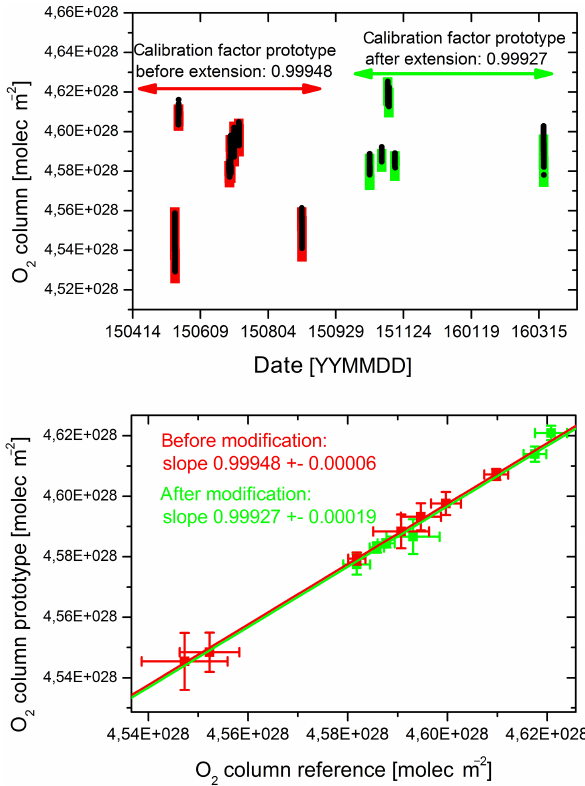
Figure 8. Total column amounts of molecular oxygen measured with the EM27/SUN used as a reference (data in black) and the prototype before and after the implementation (before: red; after: green) of the secondary channel. The implemented extension did not affect the characteristics of the prototype. Upper panel: time se- ries of the O 2 column amounts as recorded with the reference spec- trometer and the prototype. Lower panel: Mean daily O 2 column amounts as recorded with the prototype as a function of the values recorded with the reference spectrometer. The error bars shown are the standard deviation of the intraday scatter. The calibration fac- tors before and after the modification of the prototype are in mutual agreement.